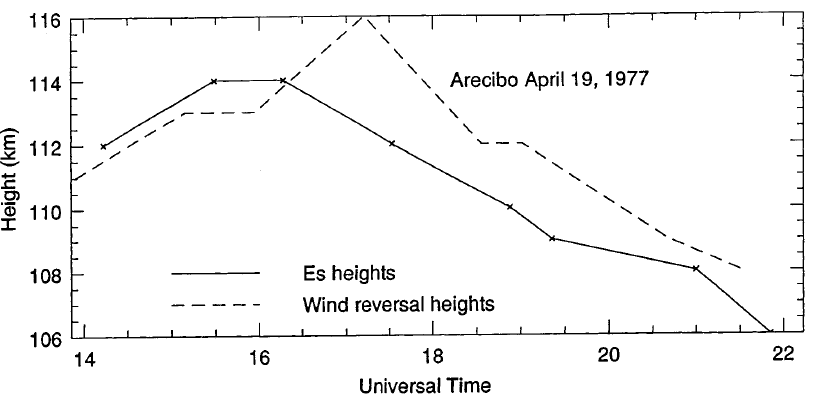
Fig. 2. Es heights and wind reversal heights variation with Universal Time determined at Arecibo as in Fig. 1 for April 19, 1977